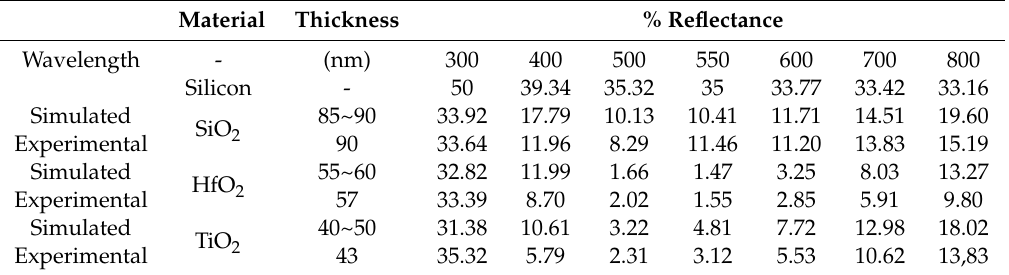
Table 1. Simulated constraints and experimentally measured e ffi ciencies and thicknesses of monolayer inorganic oxide AR coatings on a silicon substrate.